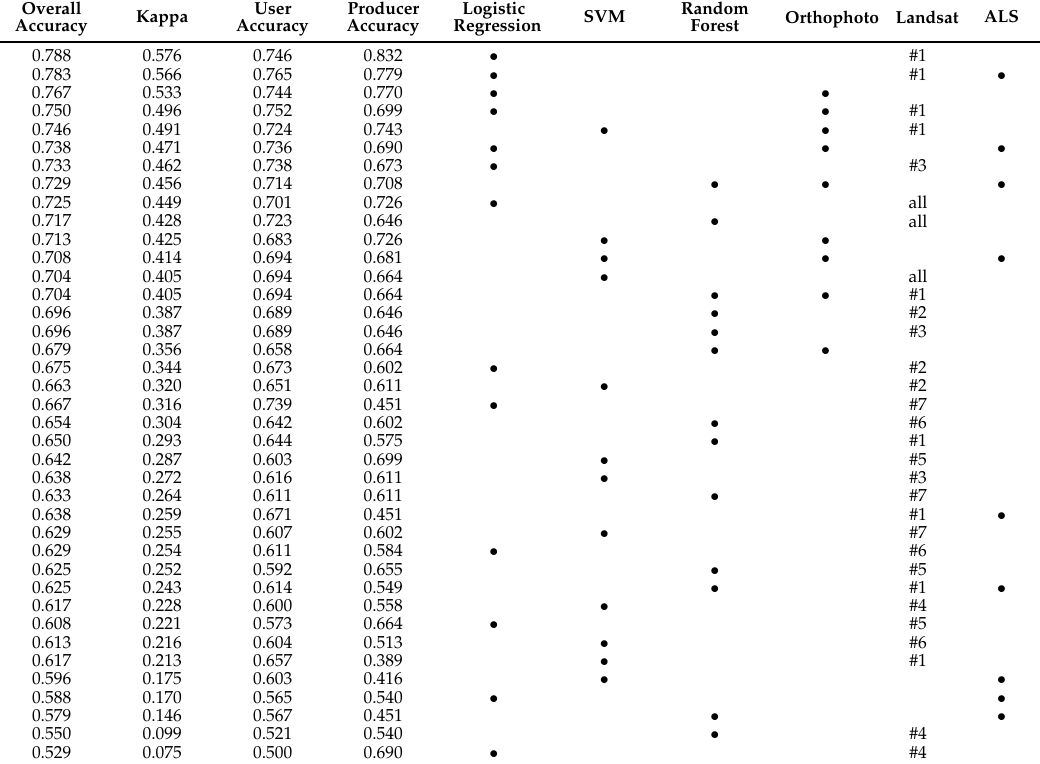
Table 4. Accuracy statistics from the cross-validation of the classification models. User and producer accuracy for the Sitka class. The table is sorted according to the kappa value, i.e. the models with best performance appear at the top of the table. The use of data from individual or a combination of all seven Landsat images are indicated by image number (see Section 2.3.1 for dates of individual images). The dots indicate the combination of classification algorithm and datasets